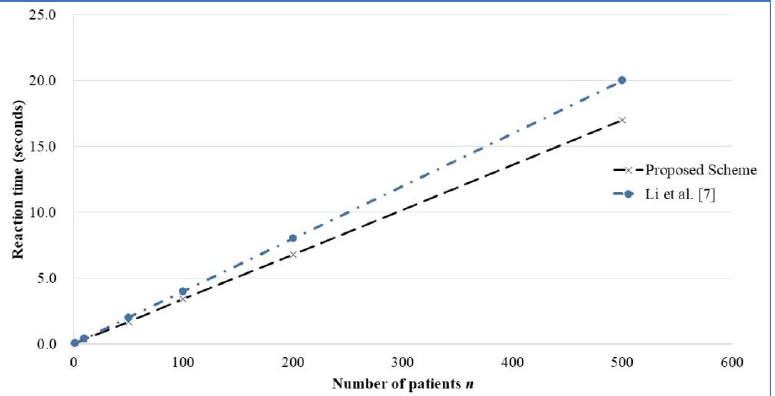
Figure 5. The reaction time of social network information transmission stage of Li et al. and pro- posed one.